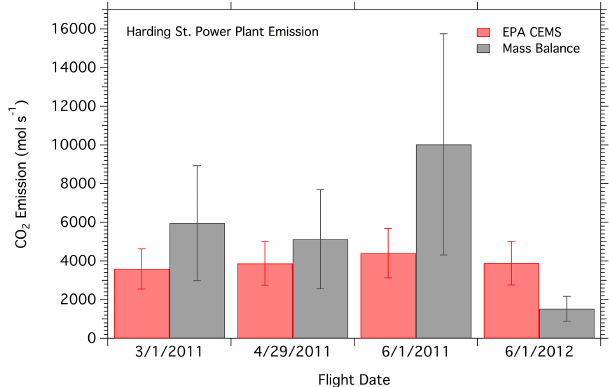
Figure 8. Harding Street power plant CO 2 emission estimates from the mass balance and EPA CEMS monitoring approaches. Error bars in the CEMS monitoring represent a 29% uncertainty while error bars in the mass balance approach correspond to the 50% un- certainty